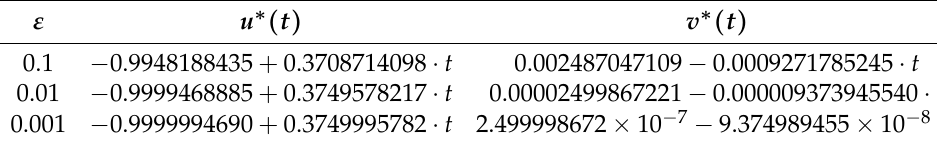
Table 2. The inner minimizer and maximizer for varying ε .